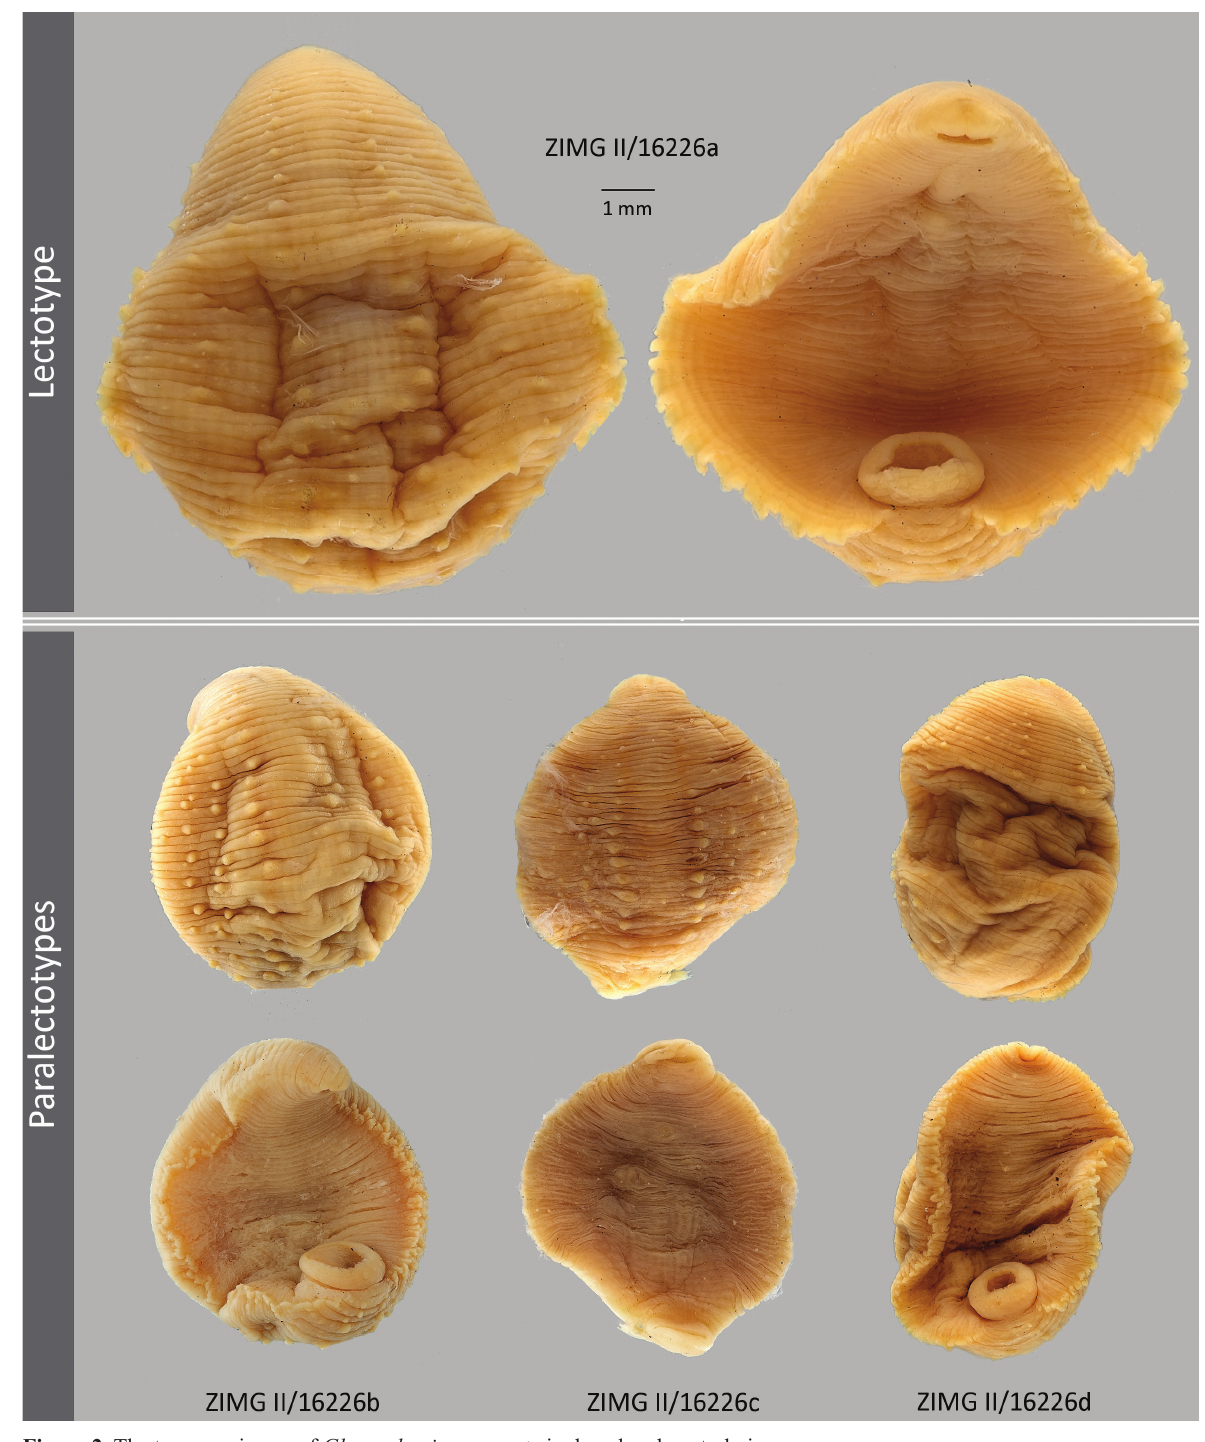
Figure 2. The type specimens of Glossophonia verrucata in dorsal and ventral